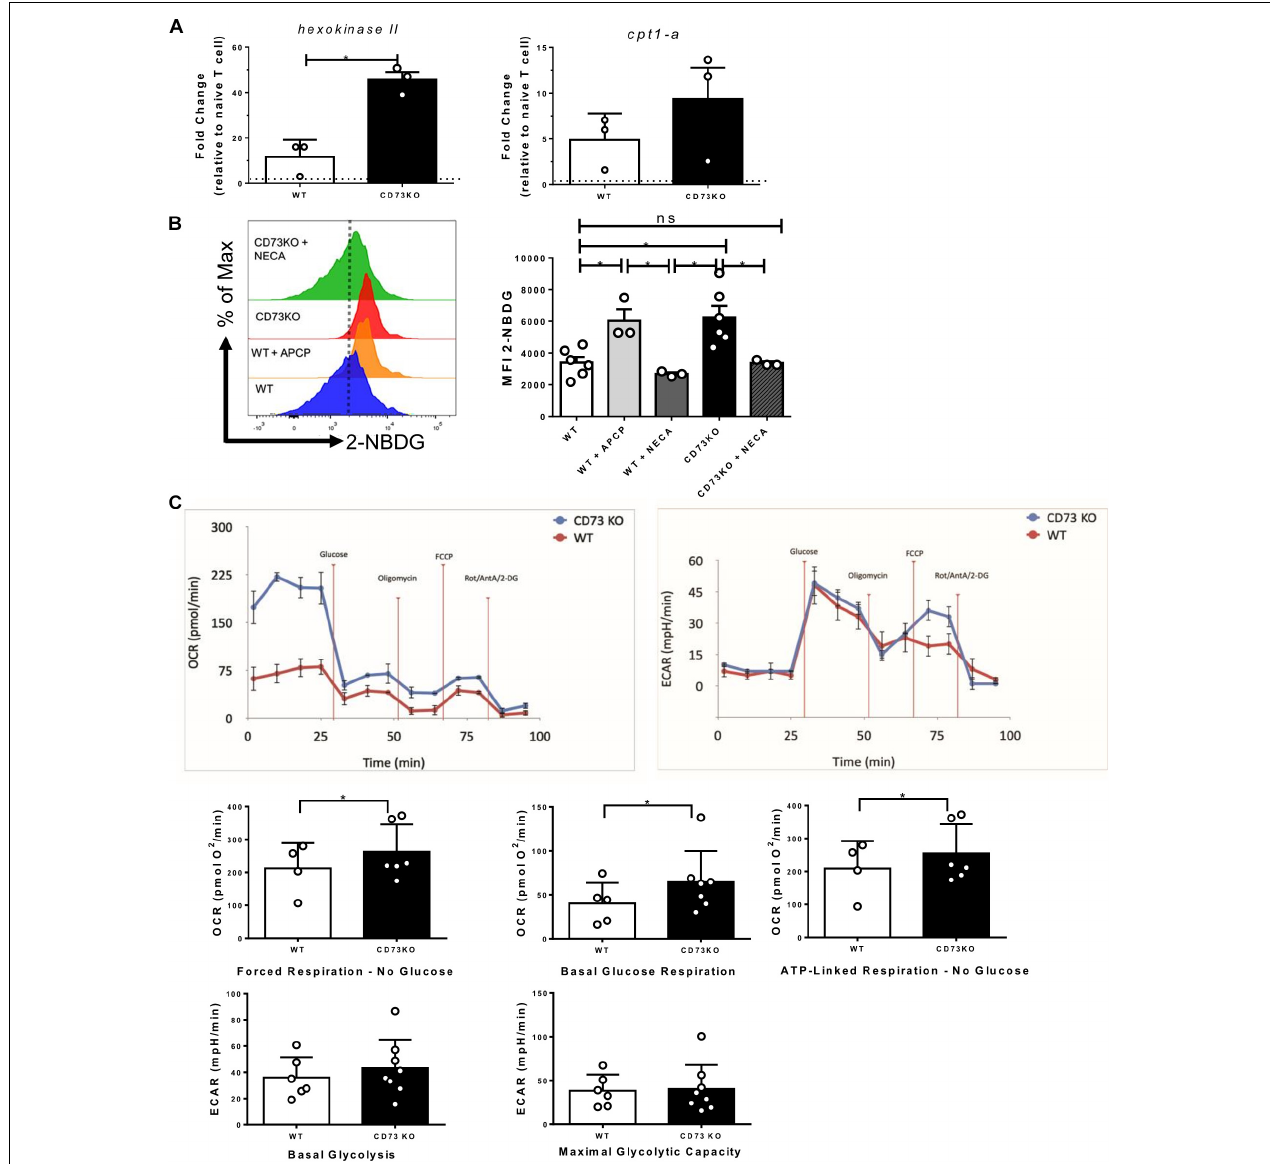
FIGURE 4 | CD73 restricts the mitochondrial capacity of Tc1 cells. Naive CD8+ T cells from WT mice were isolated and activated with soluble α -CD3/CD28 antibodies for 3 days in vitro in the presence of IL-2 (10 ng/ml) for the generation of Tc1 lymphocytes. (A) Expression of hexokinase II and cpt-1 mRNAs was analyzed by real-time PCR in CD73 and WT Tc1 cells ( n = 3). (B) Glucose uptake of WT and CD73KO Tc1 cells treated with APCP (50 µ M) or NECA (10 µ M) was measured by FACS using the fluorescent glucose analog 2-NBDG ( n = 3–6). (C) Left panel: Oxygen consumption rates (OCRs) and Right panel: extracellular acidification rates (ECARs) from CD73KO and WT Tc1 cells were measured under no glucose (forced mitochondrial respiration), basal glucose respiration and ATP-linked respiration for OCR and basal glycolysis and oligomycin stimulated glycolysis (maximal glycolytic capacity) for ECAR ( n = 4;6 Tc1 WT and 8 CD73KO